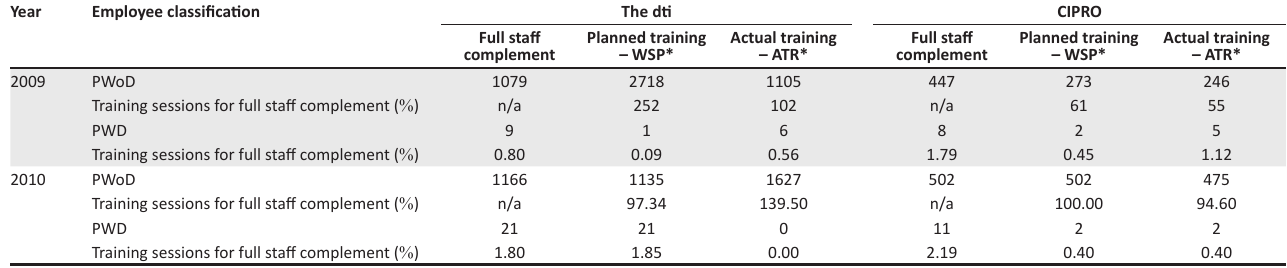
TABLE 3: Training statistics for the Department of Trade and Industry and the Companies and Intellectual Property Registration Office